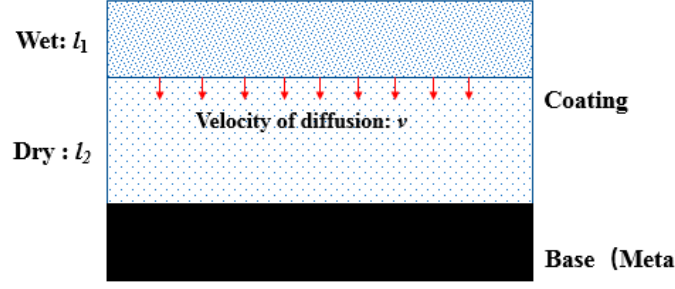
Figure 7. Assumption of water di ff usion uniformly.